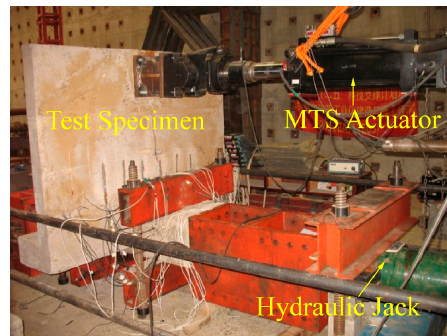
Figure 15. The test site.